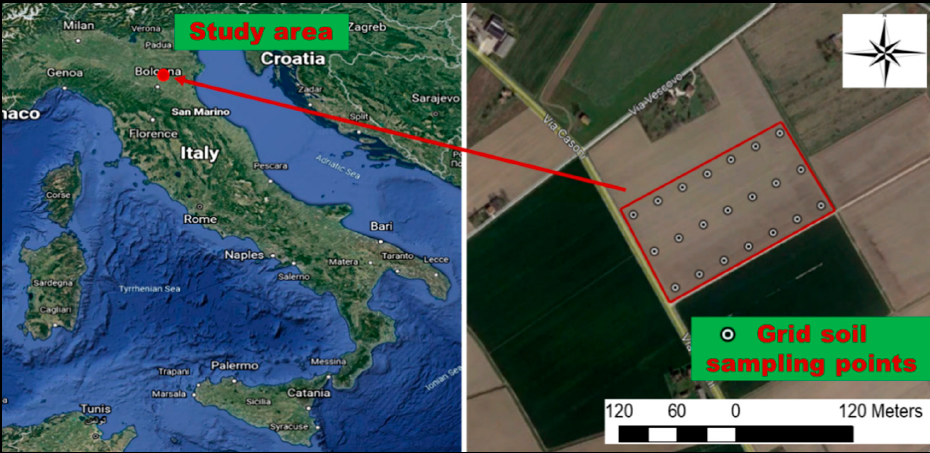
Figure 1. Study site and soil sampling points across the field located in Northern Italy.